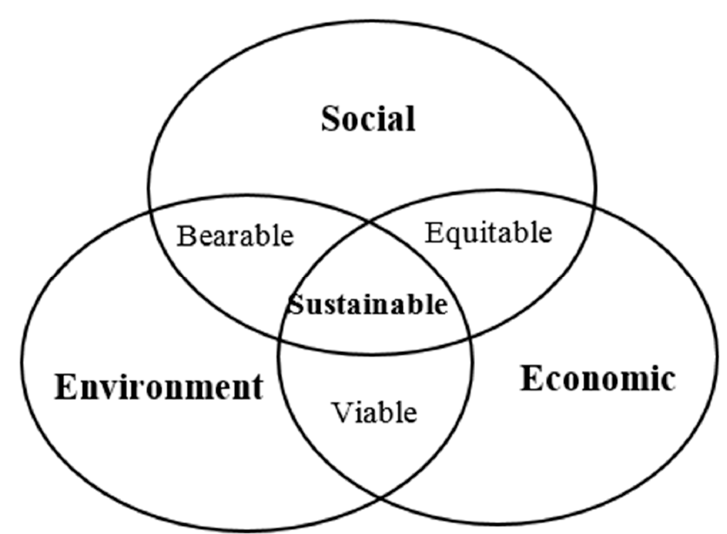
Figure 2. Three pillars of sustainability.